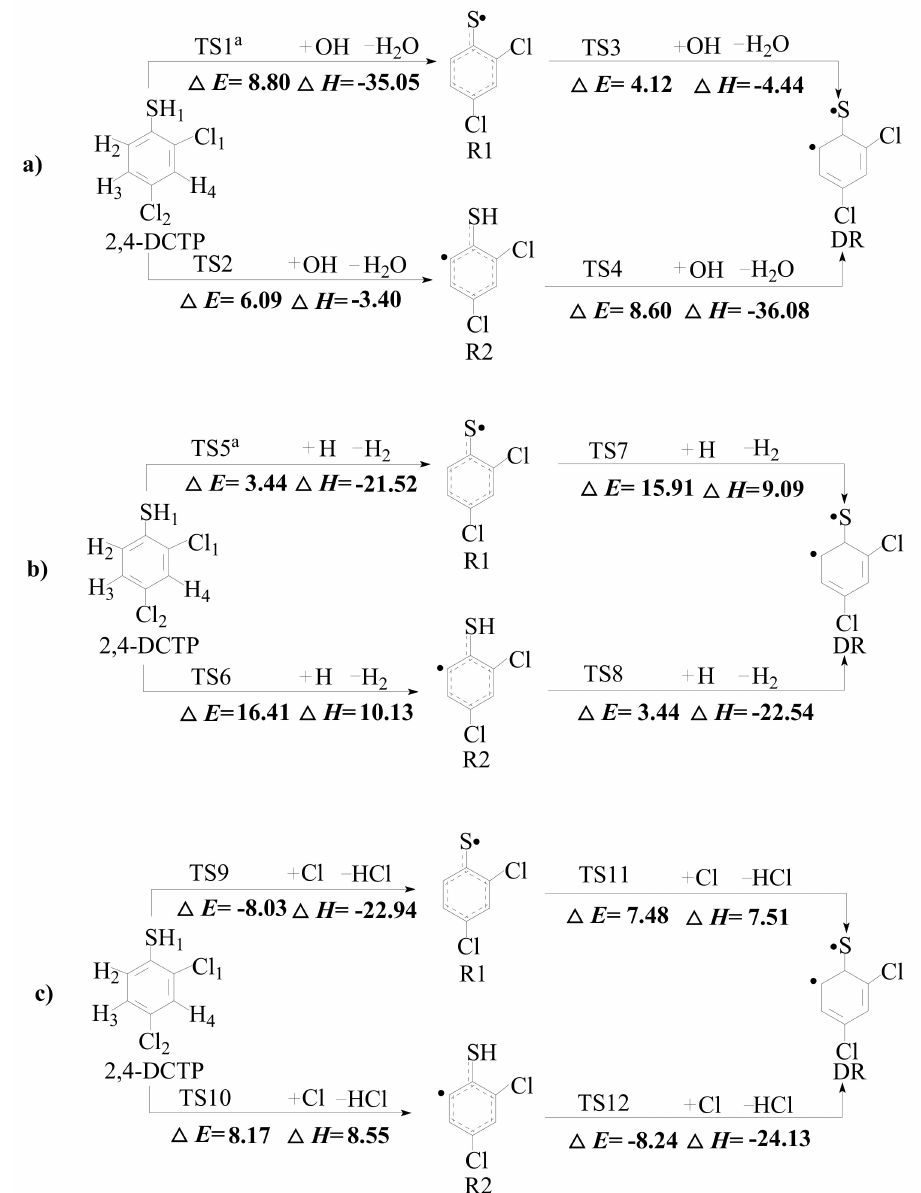
Figure 1. Schematic formation of various radicals from the reactions of 2,4-DCTP with OH ( a ), H ( b ) and Cl ( c ) with the potential barriers ∆ E (in kcal / mol) and reaction heats ∆ H (in kcal / mol). ( a Reproduced with permission from Xu et al.